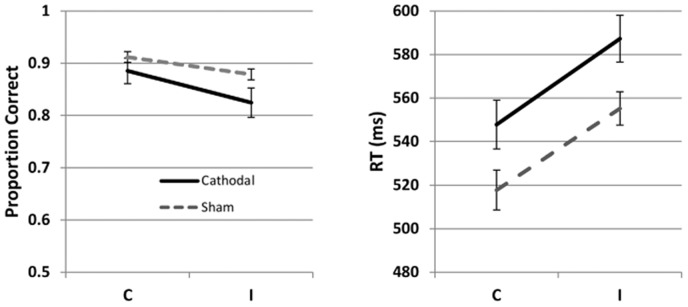
Mean accuracy and reaction times (± SE) in the Flanker task in Experiment 1.The left panel shows mean accuracy, and the right panel shows reaction times. C  =  Congruent; I  =  Incongruent.